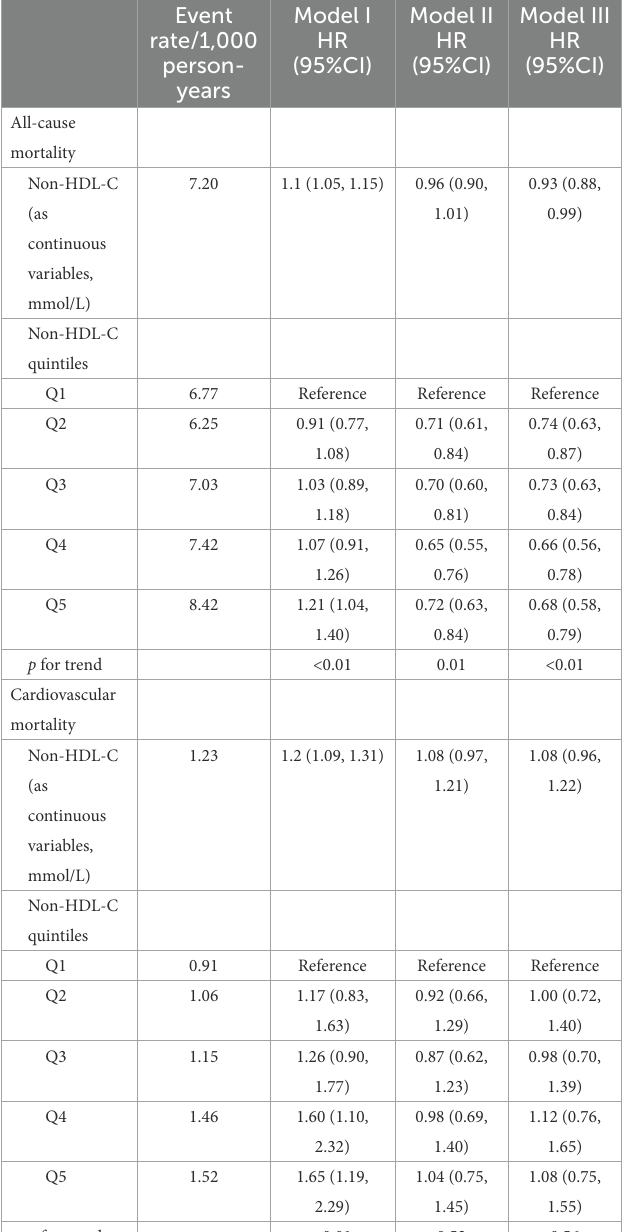
TABLE 2 Multivariate cox regression analysis of non-HDL-C with cause- specific mortality.